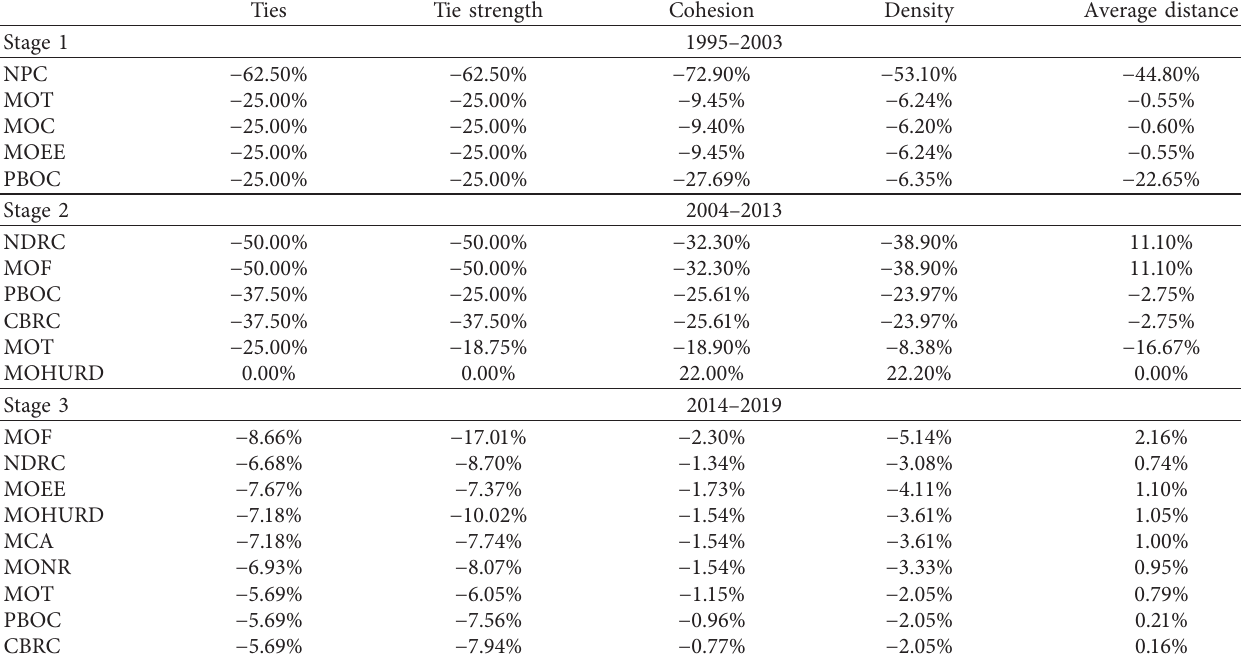
Table 5: Change of the network when omitting each core policy